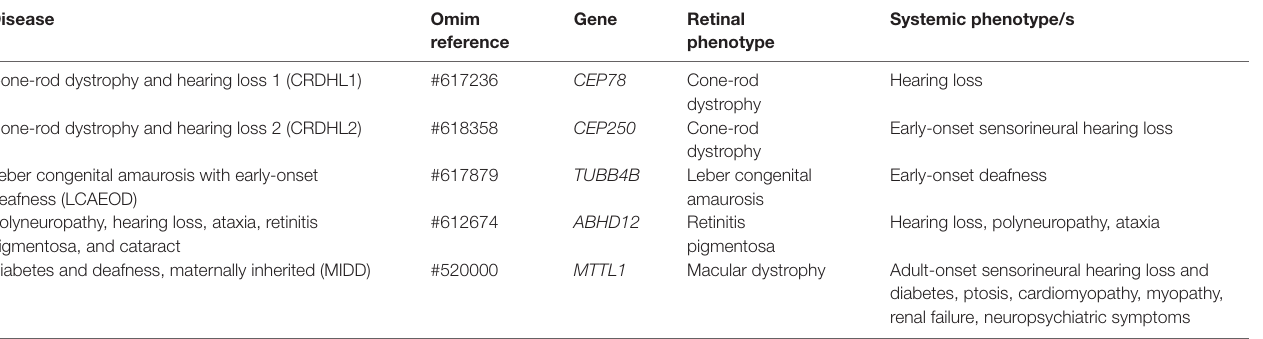
TABLE 2 | List of non-Usher syndromes that cause hearing loss and inherited retinal disease.